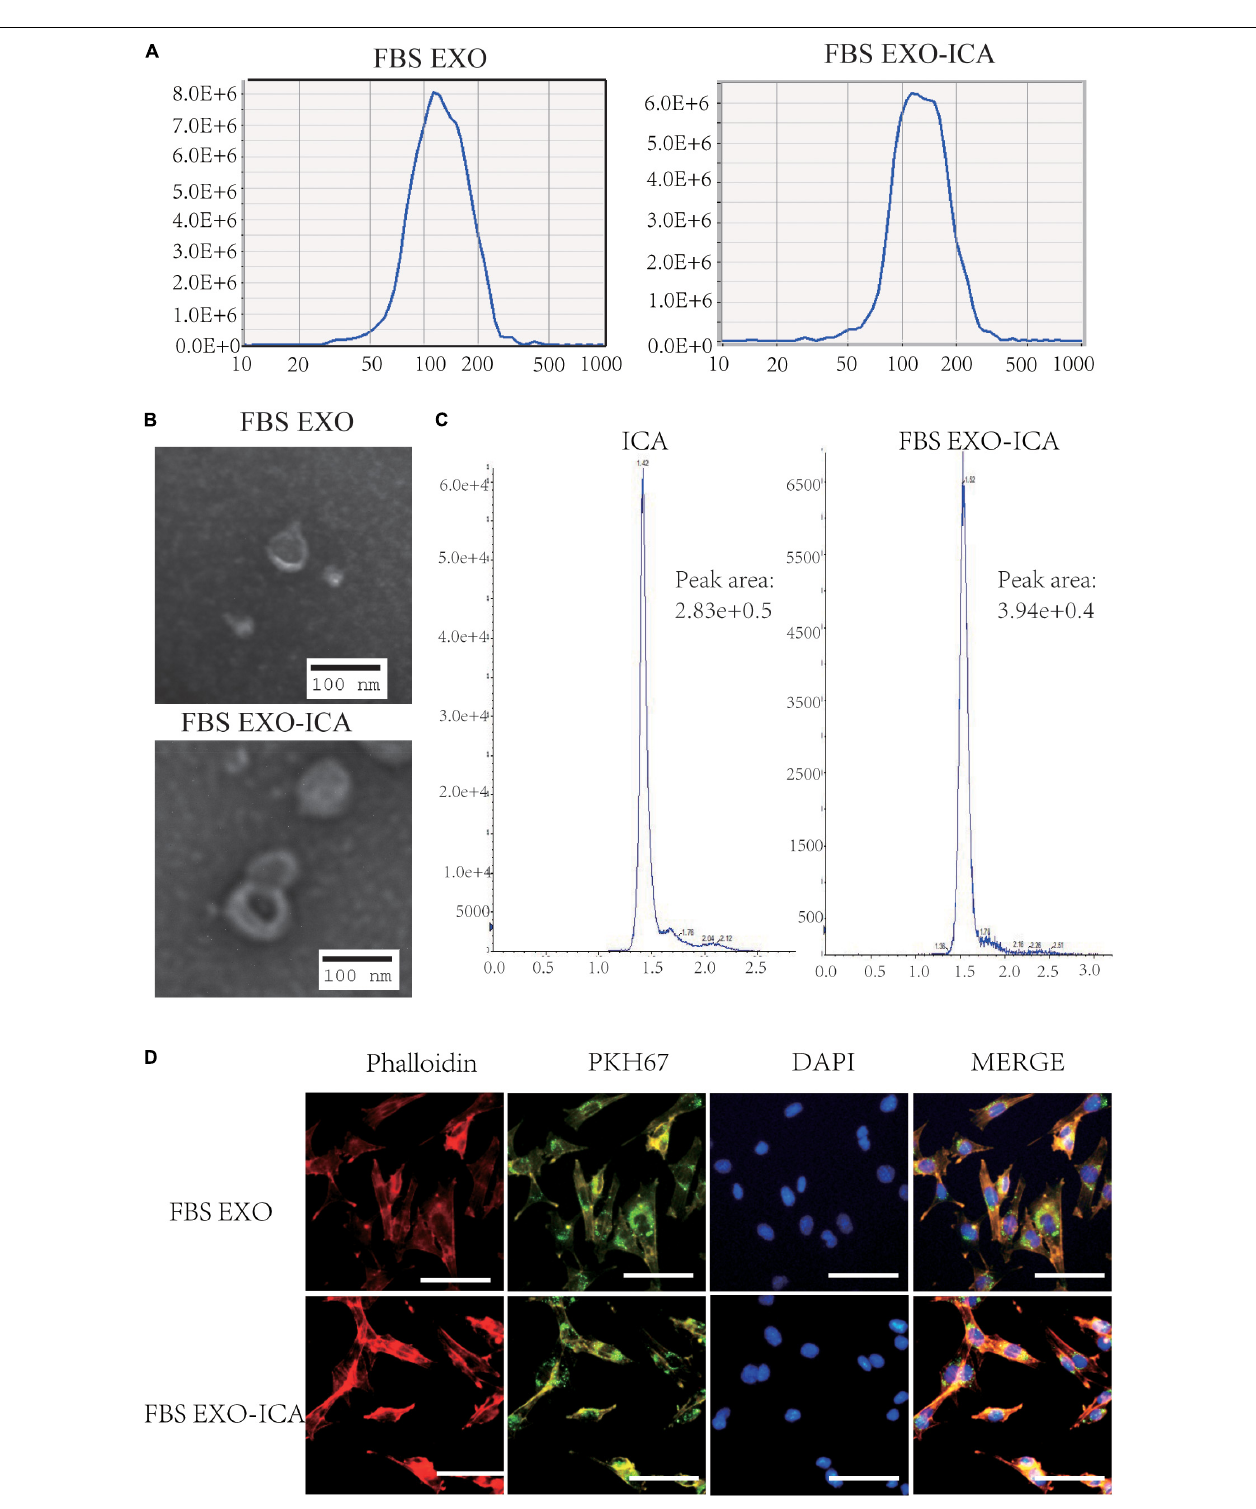
FIGURE 4 | Construction and identification of FBS EXO-ICA. (A) Particle sizes of FBS EXO and FBS EXO-ICA detected by NTA; (B) TEM results showing the typical lipid bilayer membrane structure and diameter of FBS EXO-ICA ( × 8,000); (C) HPLC indicating the extent of incorporation of ICA in FBS EXO; (D) Fluorescence staining showing that phalloidin labeled the cytoskeleton red, PKH67 labeled the exosome membranes green, and DAPI labeled the cell nuclei blue ( × 200).